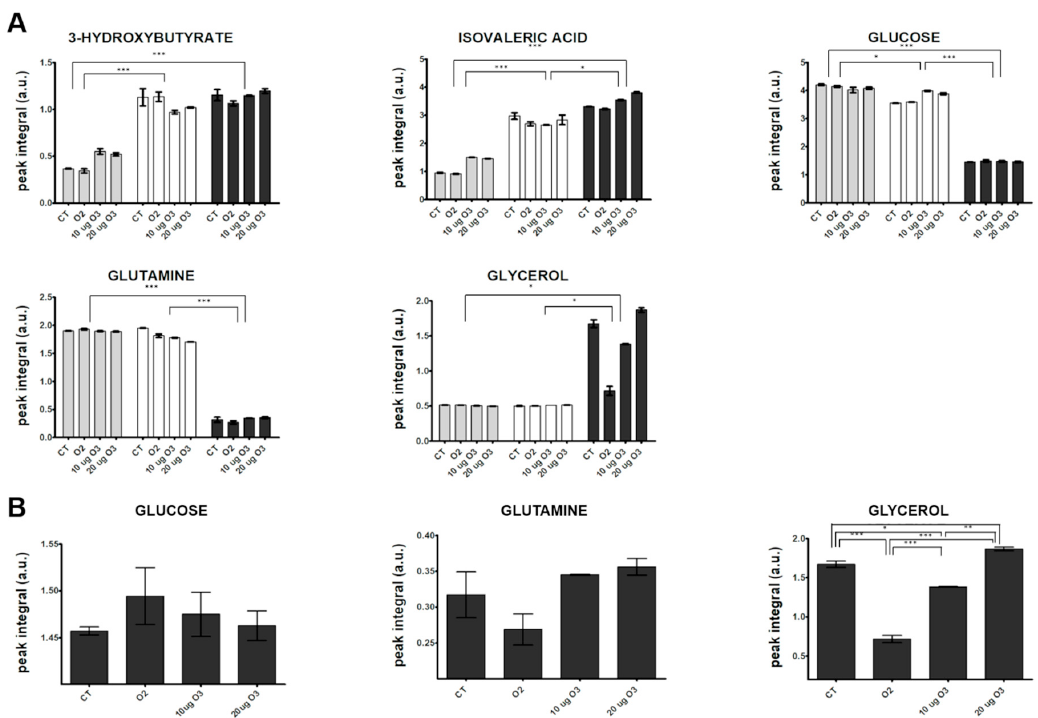
Figure 5. Changes in the relative concentration (arbitrary NMR integral units, mean values ± SE, n = 2) of selected metabolites in the media at different incubation times post-treatment of AT culture (2 h: grey; 24 h: white; 48 h: dark grey) ( A ) and among the different samples at 48 h ( B ). CT, control. Significant statistical differences are indicated as *** p ≤ 0.001, ** p ≤ 0.01 and * p ≤ 0.05.